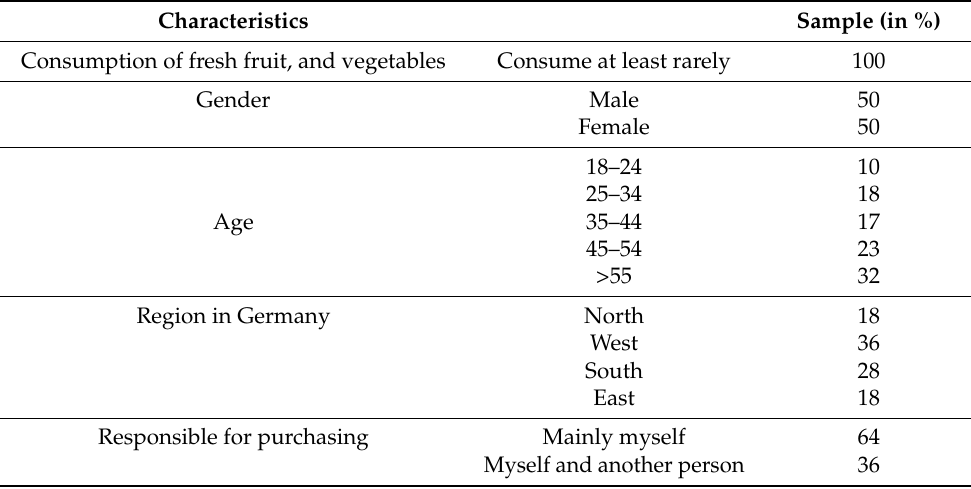
Table 1. Attributes of the consumer sample (specified criteria for approximate representativeness).